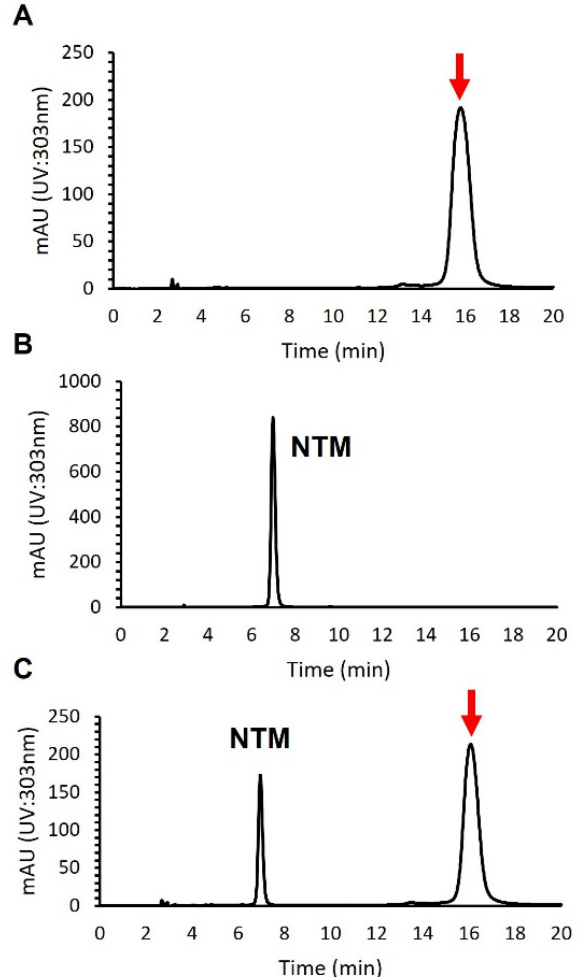
Figure 2. HPLC analysis of an antifungal compound isolated from S. achromogenes subsp. strepto- zoticus NBRC14001: ( A ) an antifungal compound from NBRC14001; ( B ) NTM; ( C ) co-injection of an antifungal compound from NBRC14001 and NTM. A red arrow indicates the peak of isolated compound.